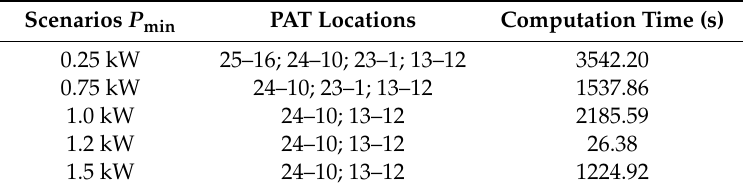
Table 2. Optimal Locations of pumps as turbines